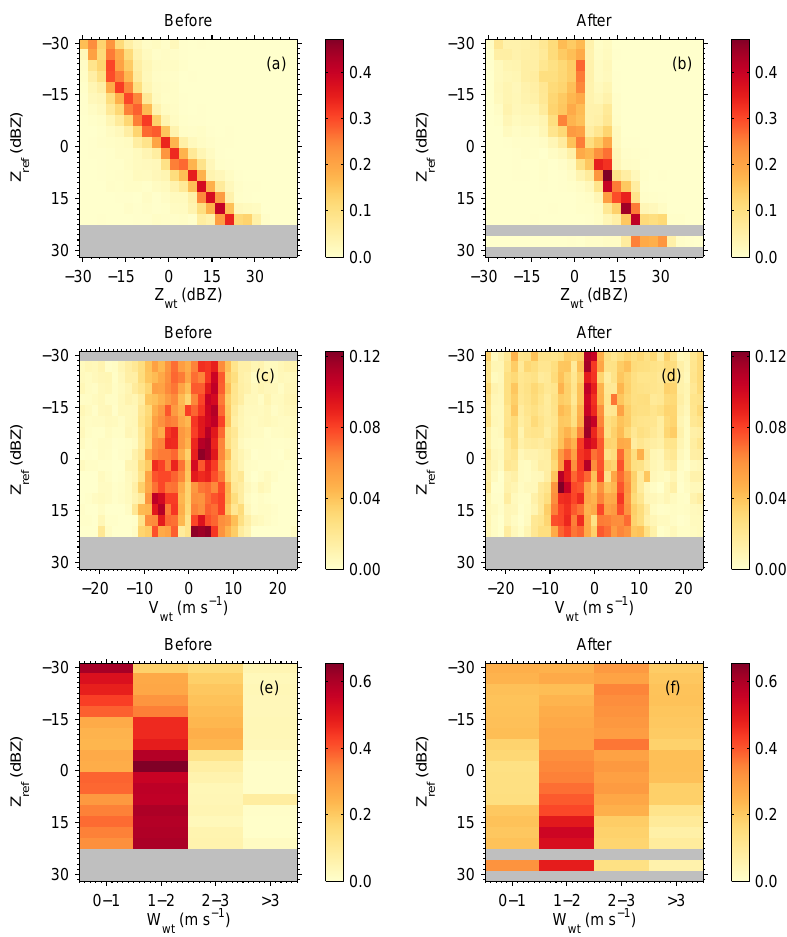
Figure 7. Relative frequency distributions of reflectivity, Z wt ; radial velocity, V wt ; and spectrum width, W wt , from a radar cell in which three wind turbines are located as a function of reflectivity from a reference radar cell, Z ref , using data from the scan with the lowest tilt angle ( θ = 0 . 5 ◦ ). Panels on the left-hand side ( a , c , and e ) show relative frequency distributions before the wind farm was constructed, and panels to the right ( b , d , and f ) show the corresponding distributions after the wind farm start of operations. For Z ref (cid:38) 5dBZ the distributions of Z wt , V wt , and W wt are similar before and after the construction of the wind farm. However, for Z ref (cid:46) 5dBZ the distributions before and after the construction of the wind farm look